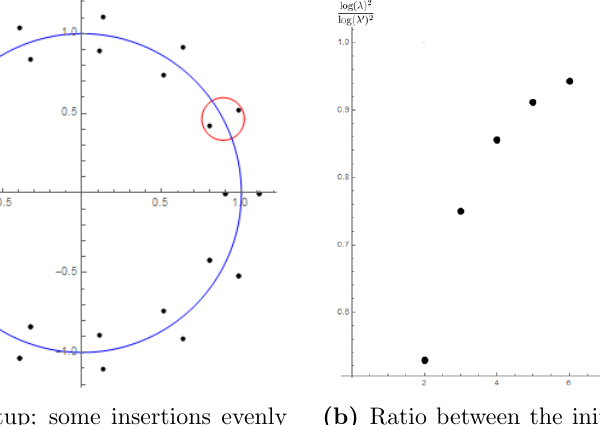
Figure 4. Colliding multiple conical